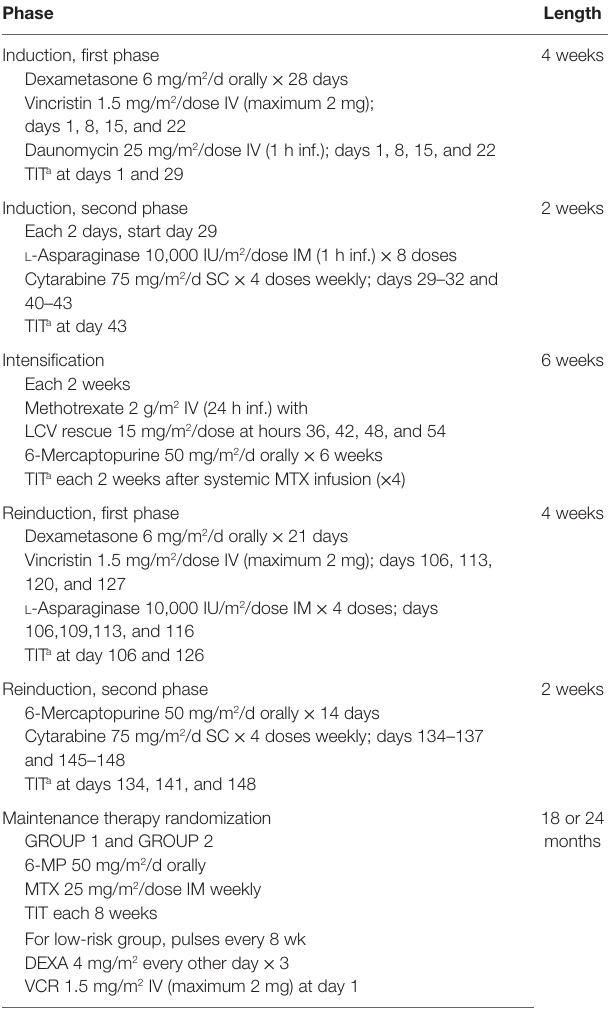
TaBle 1 | Therapy for very low-risk and low-risk all patients on gBTli all-93